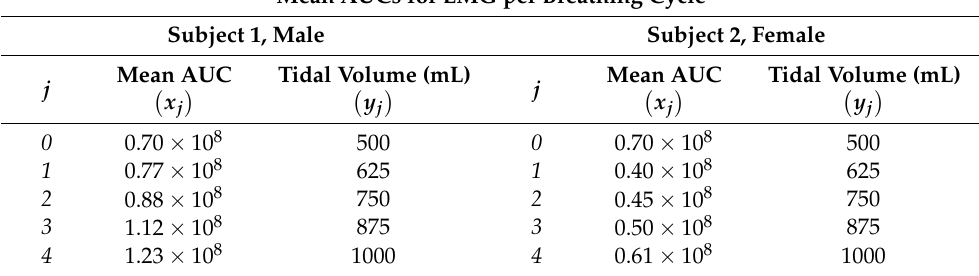
Table 4. Mean AUC for EMG per breathing cycle for different tidal volumes. EMG data collected by sensors at the